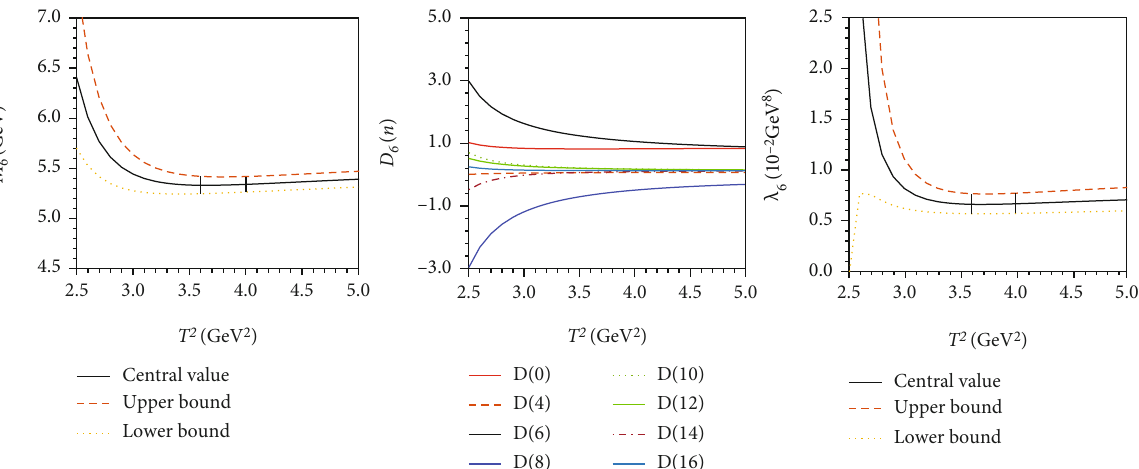
− T 2 for (a), dashed curve is drawn from the upper values of the input parameters and dotted : M 6 6 ð n Þ − T 2 for (b); λ − T 2 for (c), dashed curve is drawn from the upper values of the input parameters 6 6